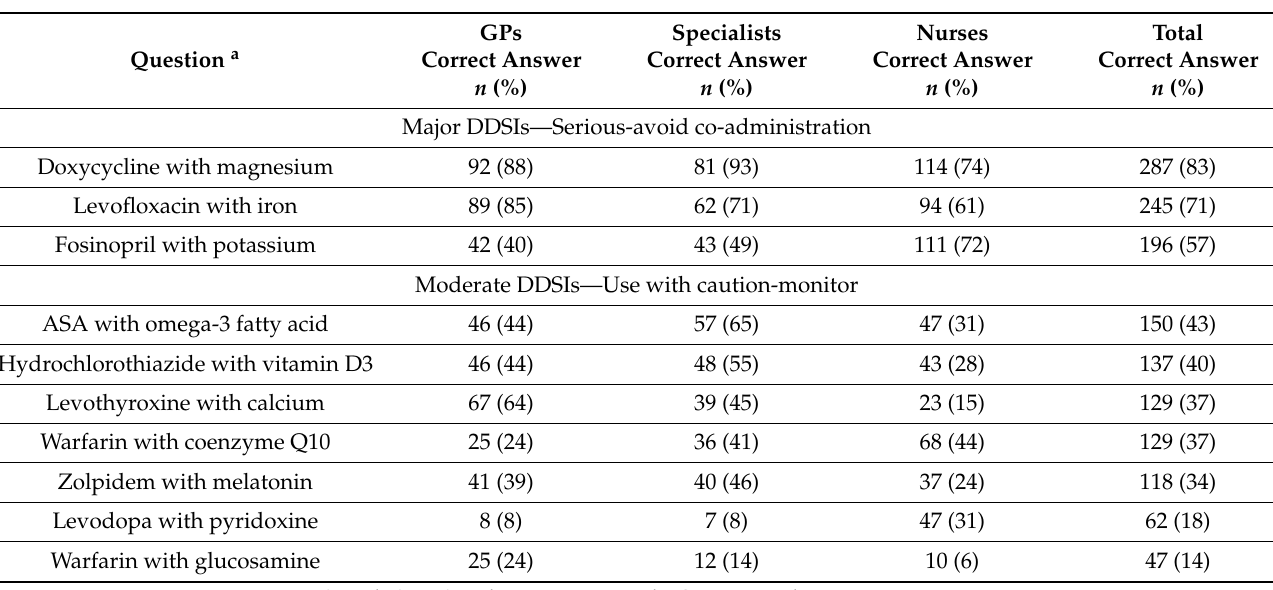
Table 2. Frequency of correct answers about drug-dietary supplement interactions (DDSIs) among respondents.